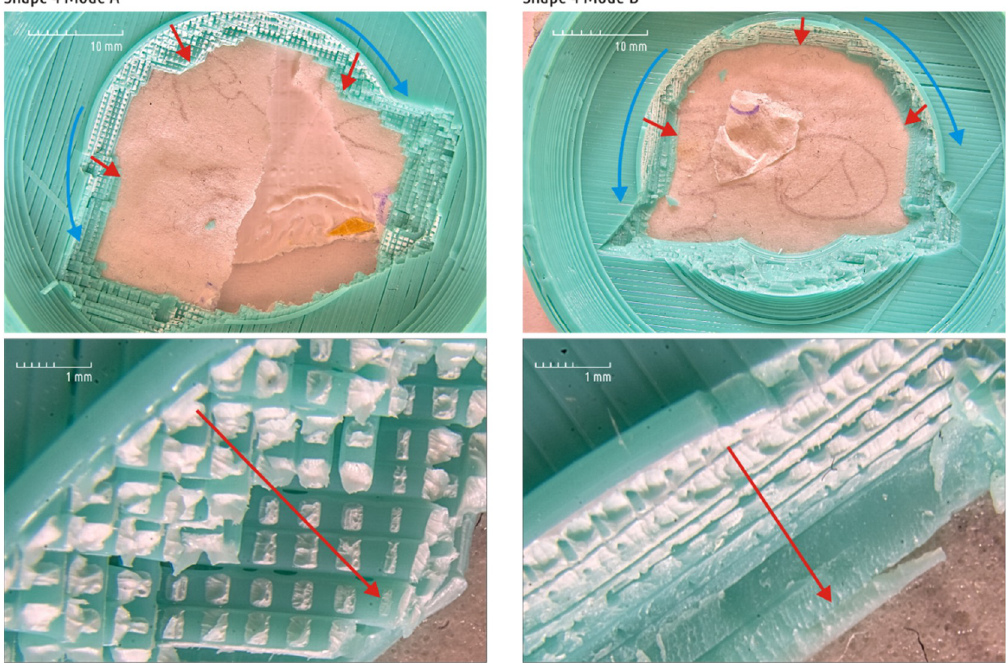
Figure 12. Fracture surface of Shape 4 samples obtained by modes A and B. The arrows indicate the direction of crack propagation.